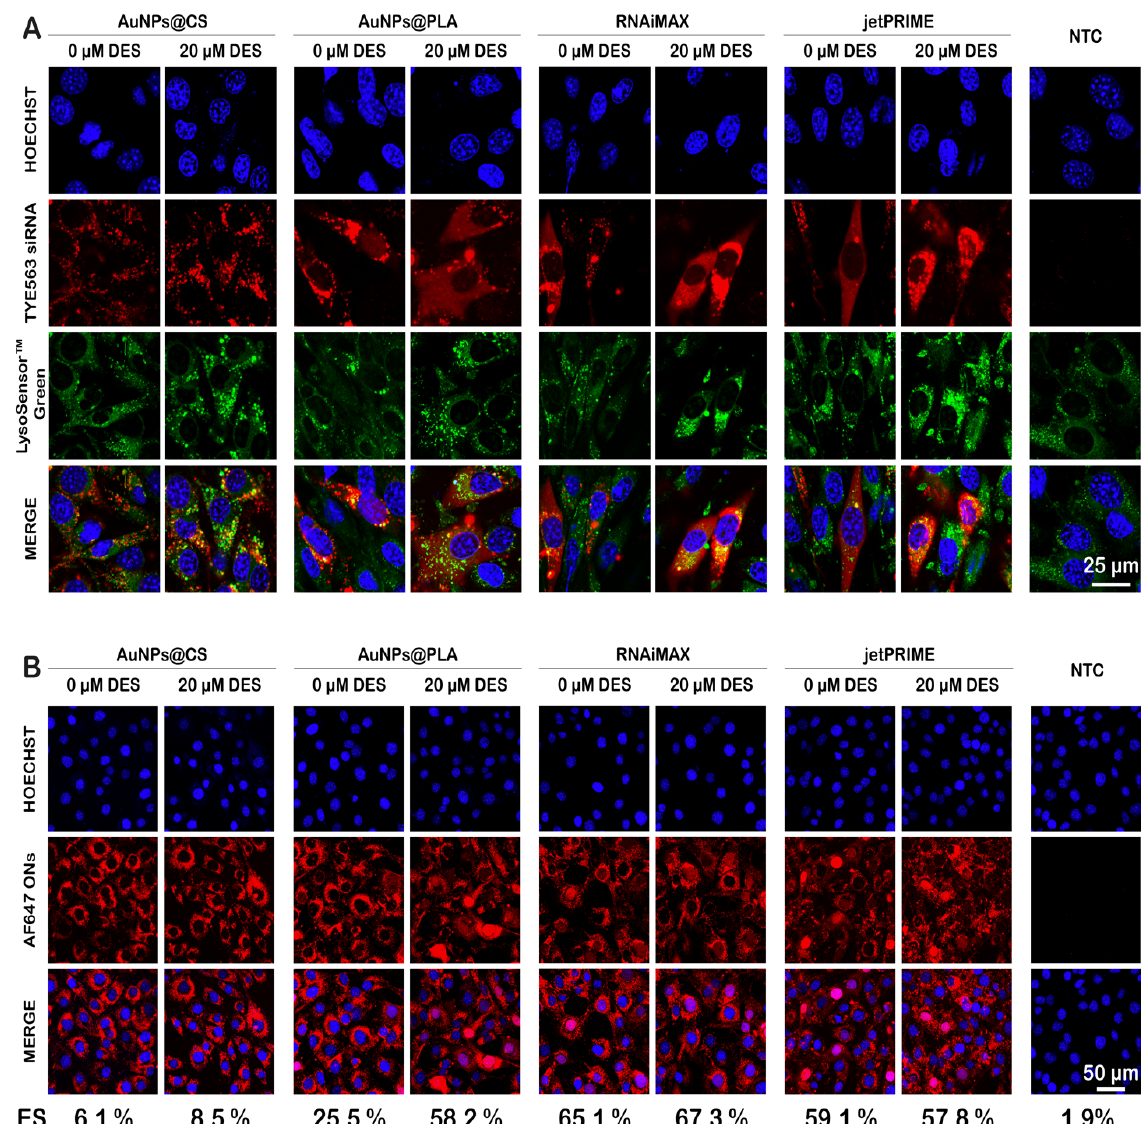
Figure 4. Uptake and endosomal escape of nanoformulations alone or in combination with DES. ( A ) Representative confocal images of NIH-3T3 cells incubated 4 h with TYE563 siRNA-loaded nanoformulations (red), followed by 20 h incubation with cell medium with or without 20 µM DES. Hoechst-stained nuclei can be seen in blue, while late endosomes and lysosomes are stained with LysoSensorTM green. The scale bar corresponds to 25 µm. ( B ) Representative confocal images of NIH-3T3 cells, incubated 4 h with AF647 ON-loaded carriers, followed by 20 h incubation with cell medium with or without 20 µM DES. Hoechst-stained nuclei can be seen in blue, while cells in which endosomal escape happened have red fluorescent nuclei due to the release of AF647 ONs, which accumulate in the nucleus. The values below the images correspond to the percentage of cells with red nuclei (endosomal escape (ES)), as determined from at least 500 cells for each case. The scale bar corresponds to 50 µm.